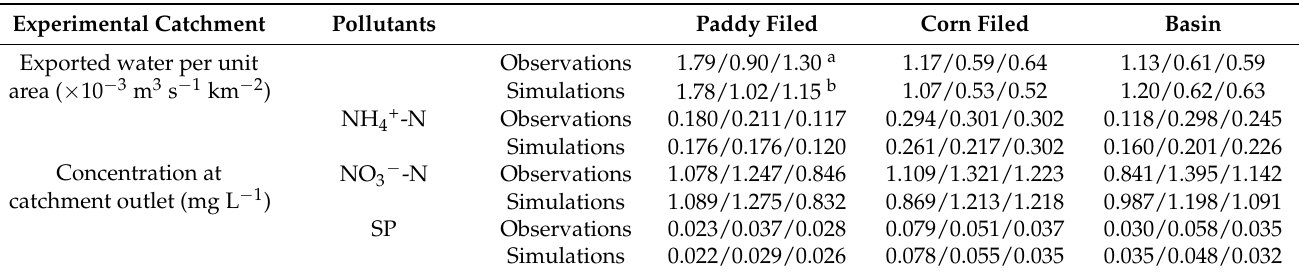
Table 4. Comparisons of simulated and monitored flow rates and pollution concentrations. Experimental